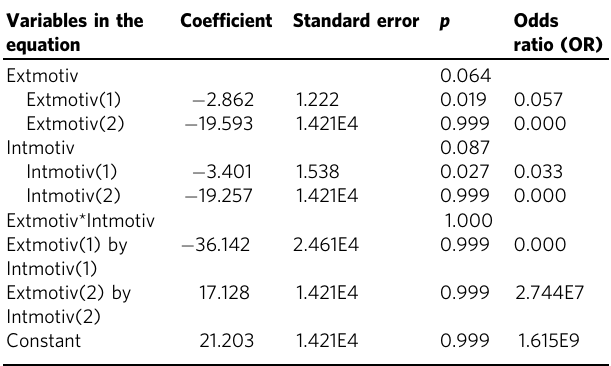
Table 6 Binary logit regression results (orgperf: dependent